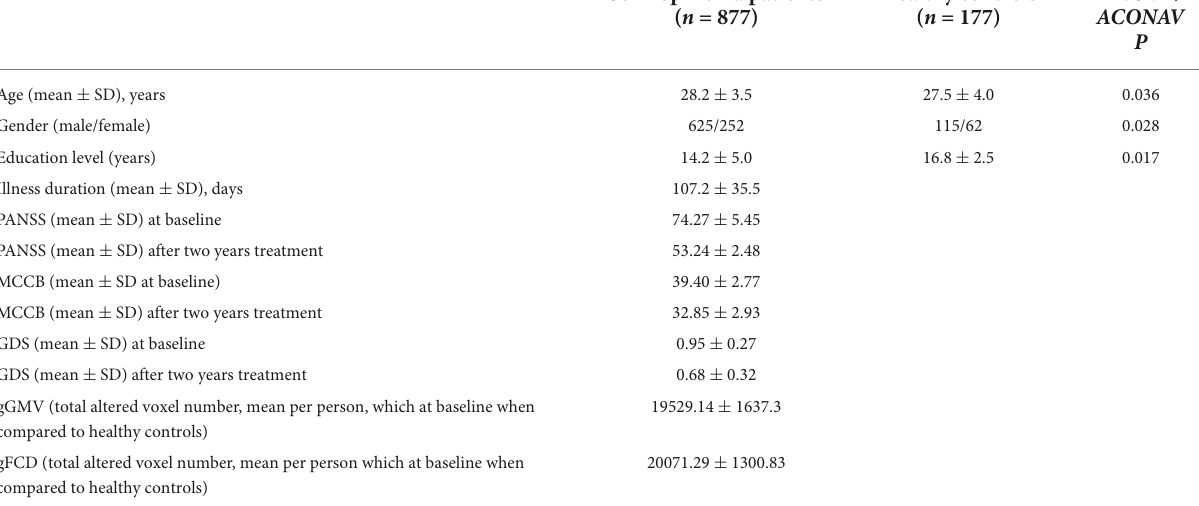
TABLE 1 Social-demographical and clinical characteristics of all the study